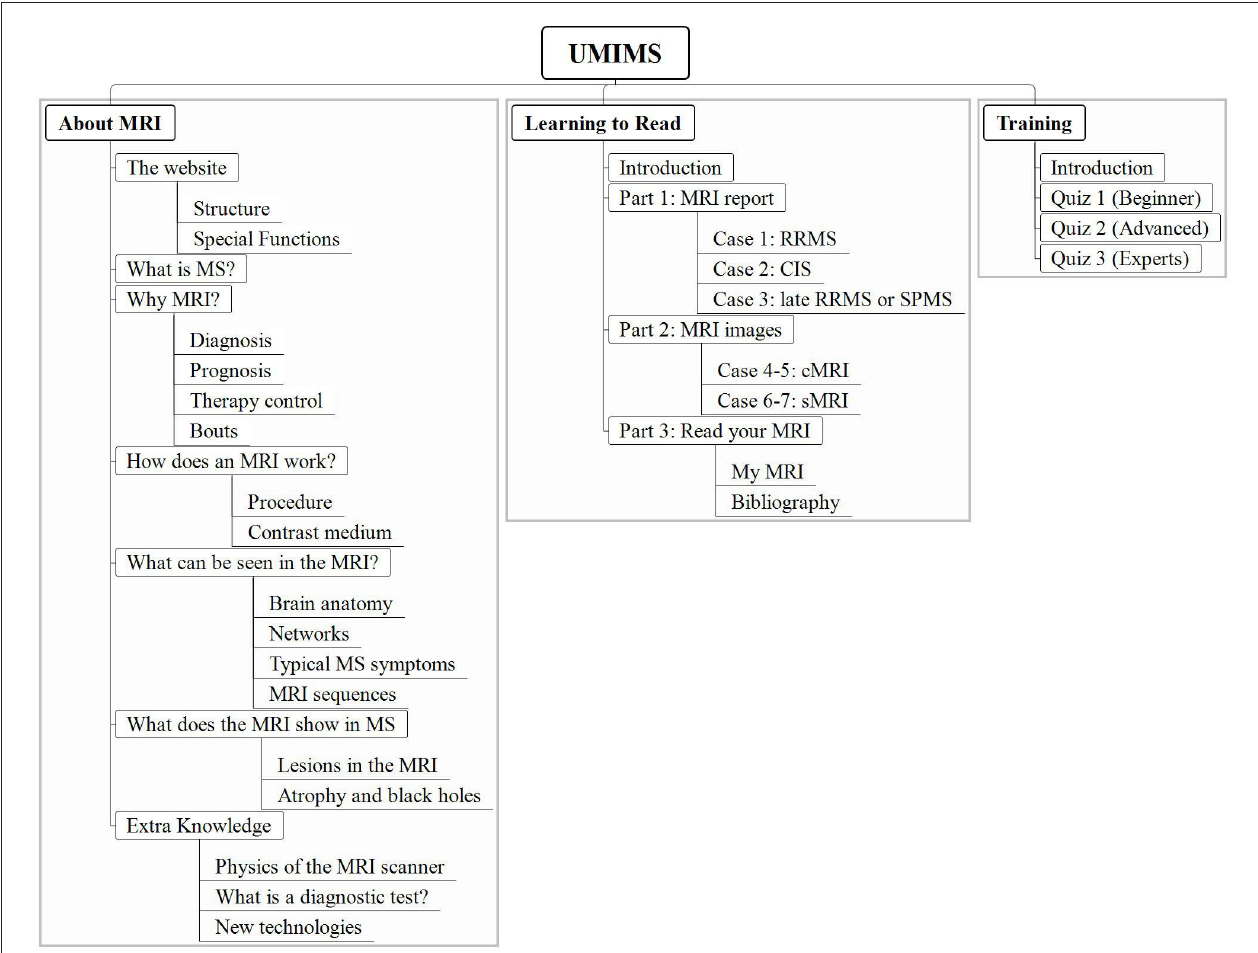
FIGURE 1 | The structure of the online education program UMIMS. Users can click on the main headings “About MRI”, “Learning to read” and “Training” to open a drop-down menu with chapters (white boxes) and subchapters (underlined). UMIMS, Understanding MRI in MS.